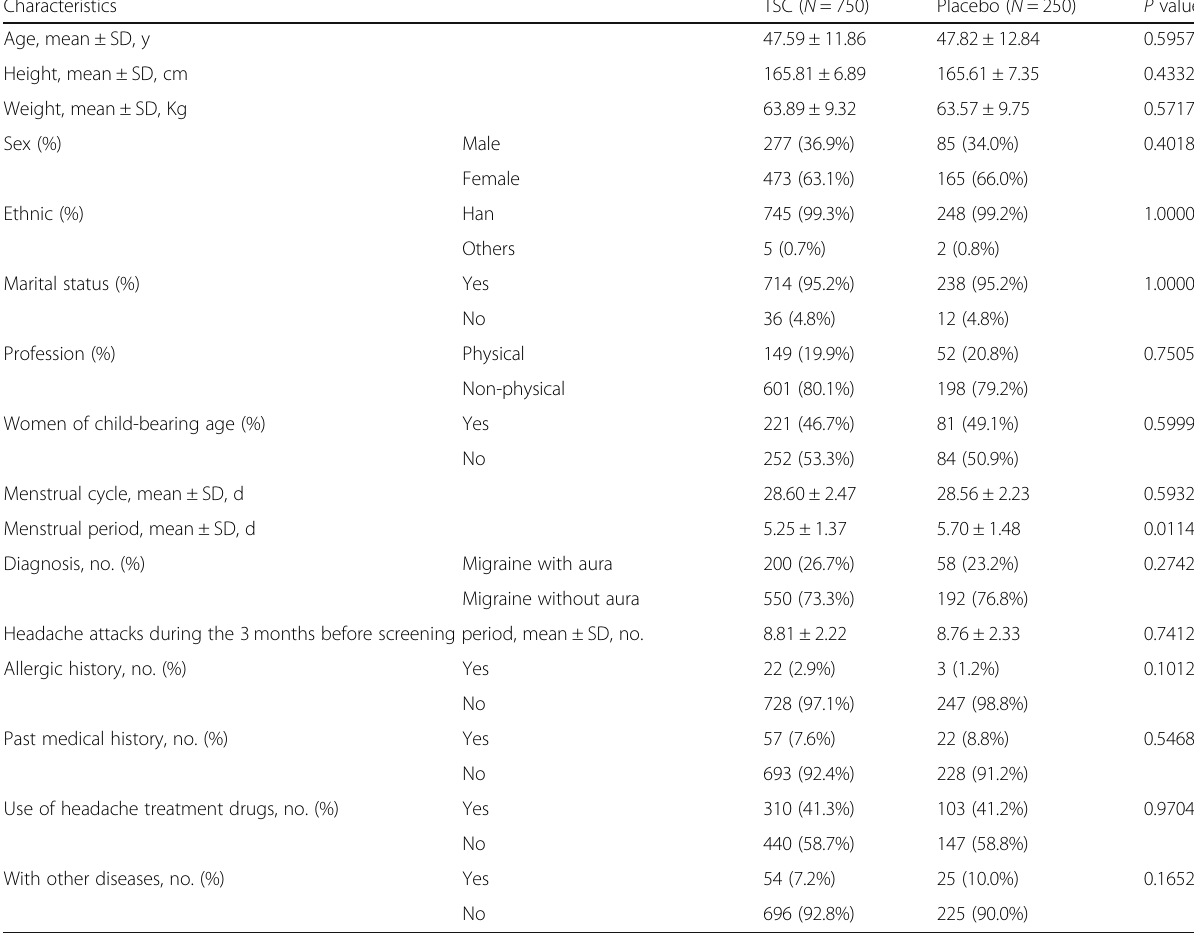
Table 2 Characteristics of patients receiving TSC and placebo